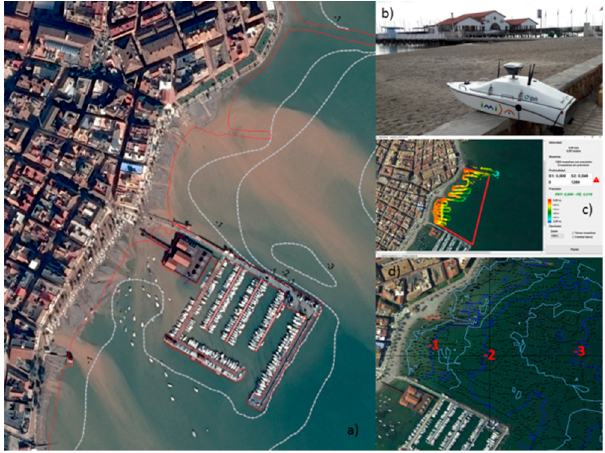
Figure 2. The topo-bathymetric work ( a ) CN Los Alcázares from a Pleiades image 20 December 2016; ( b ) IMIDA06 USV; ( c ) USV data collection software; and ( d ) Bathymetric points recorded on 30